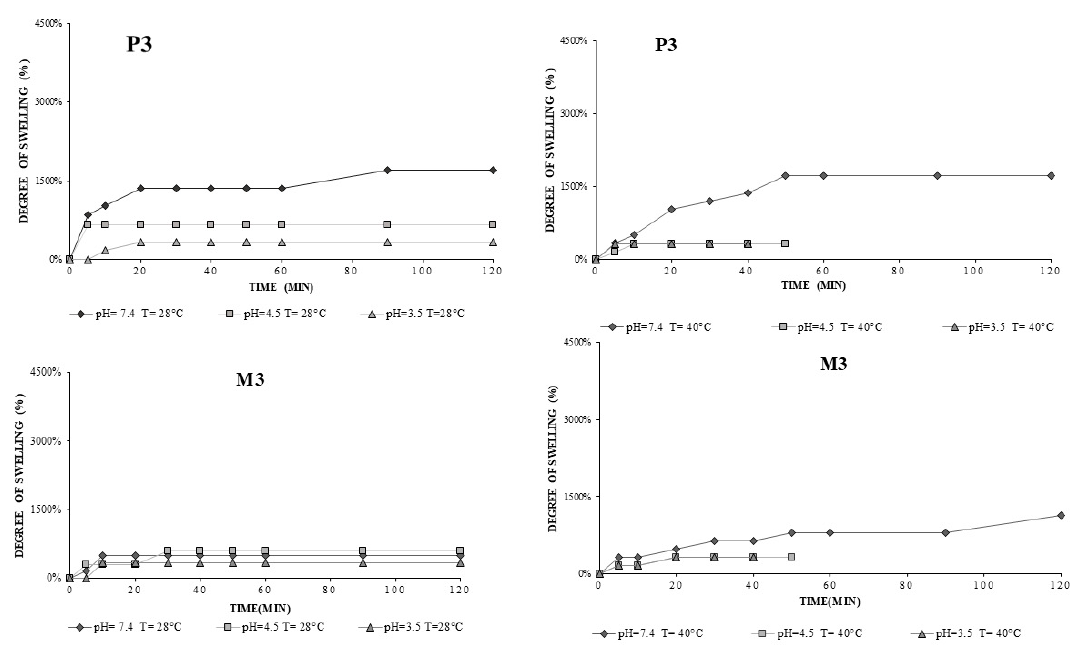
Figure 8. Swelling profiles at temperature T = 28 °C and T = 40 °C and different pH of the media for CS-g-PNIPAAm/PVA 75/25 +PGT (P3) and CS-g-PNIPAAm/PVA 75/25 (M3) hydrogels. The degree of swelling of P3 hydrogel (75/25 +PGT) reached the highest value at pH 7.4, T = 40 °C, Q = 1724% (Figure 8); under the same conditions, M3 had Q = 1129% (Figure 8), which indicates that the presence of progesterone can modify the degree of water